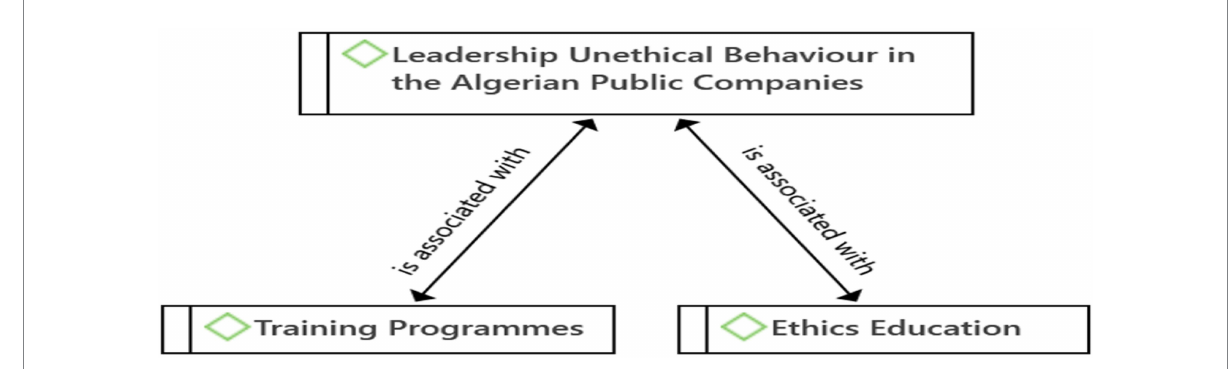
FIGURE 1 Leadership unethical behavior in the Algerian public